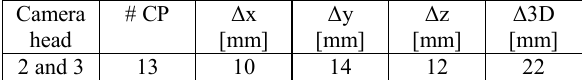
Table 4. RMSE values of study 2 for check point residuals between image-based georeferencing and